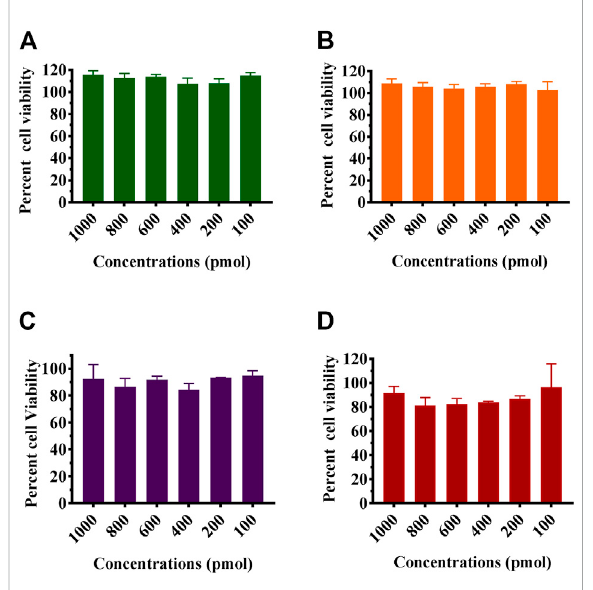
FIGURE 2 Effect of siRNA-ZIF-C (A and B) and lipofectamine (C and D) on the viability of cells using MTT assay. Vero CCL- 81 cells were treated with the ZIF-C siRNA formulations and lipofectamine siRNA formulations in serum free MEM i.e. Chik1 (A – C) , Chik5 (B – D) for 6 h and was replaced by MEM with 2% FBS. After incubation for 24 h post infection, MTT solution (5 mg/ml) was added to each well and incubated at 37 ° C for 3 h. The cells were then treated with acidi fi ed isopropanol and incubated for 1 h at 37 ° C followings which optical density was measured using a microplate reader and percent cell viability was calculated.